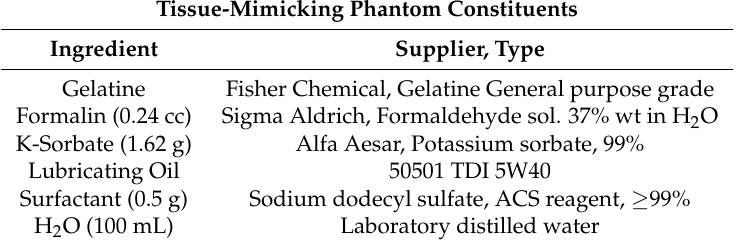
Table 1. Ingredients of the gelatine solution for the tissue-mimicking phantoms. The amount of gelatine and oil was varied for each batch (percentage specified in Table